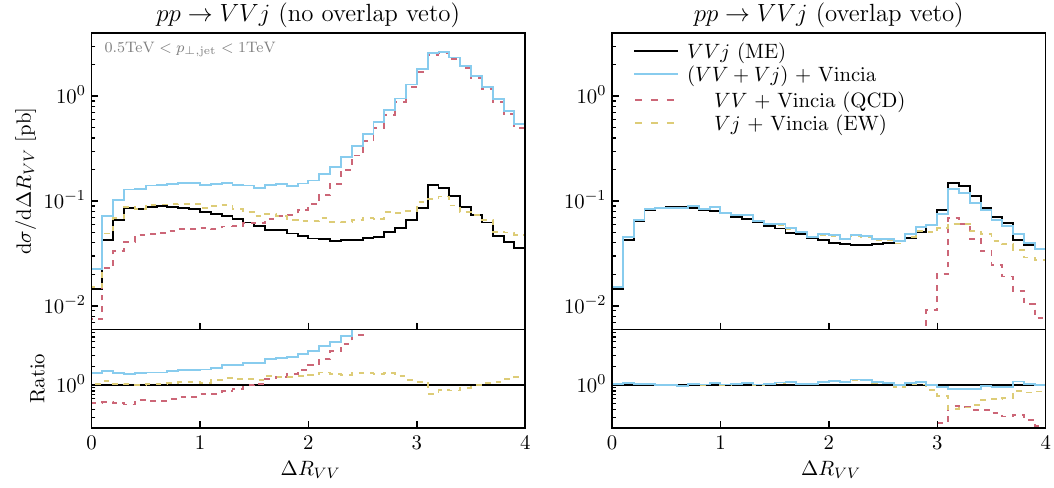
Figure 12: A comparison between the exact leading order matrix element for pp → V V j (solid black) and different shower approximations at 14 TeV. These are pp → V V + Vincia QCD (dashed red) and pp → V j + Vincia EW (dashed yellow), as well as their sum (blue). On the left-hand side the overlap veto is disabled, leading to an overcounting of the exact matrix element, while it is enabled on the right-hand side, where the matrix element is reproduced